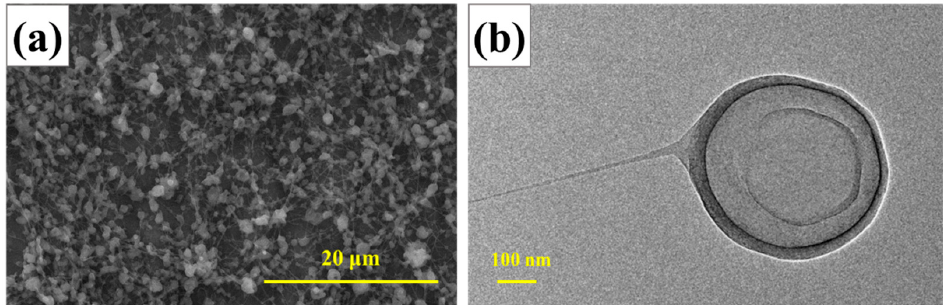
Figure 6. The images of RDX@NC (3:1) Microspheres: ( a ) SEM image; ( b ) TEM image.